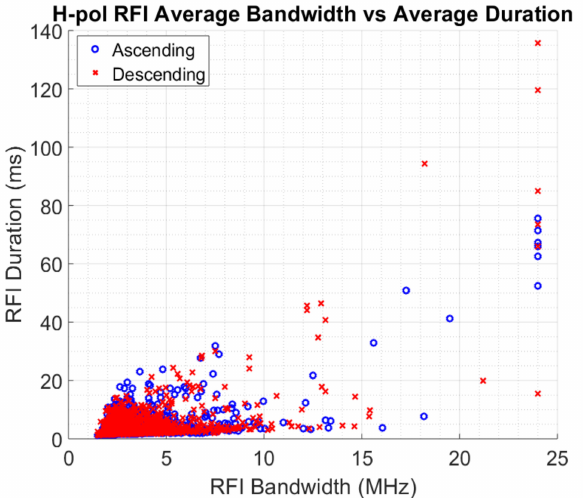
Figure 8. Bandwidth–duration characteristics of L-band H-pol RFI as observed by SMAP between 1 and 7 May